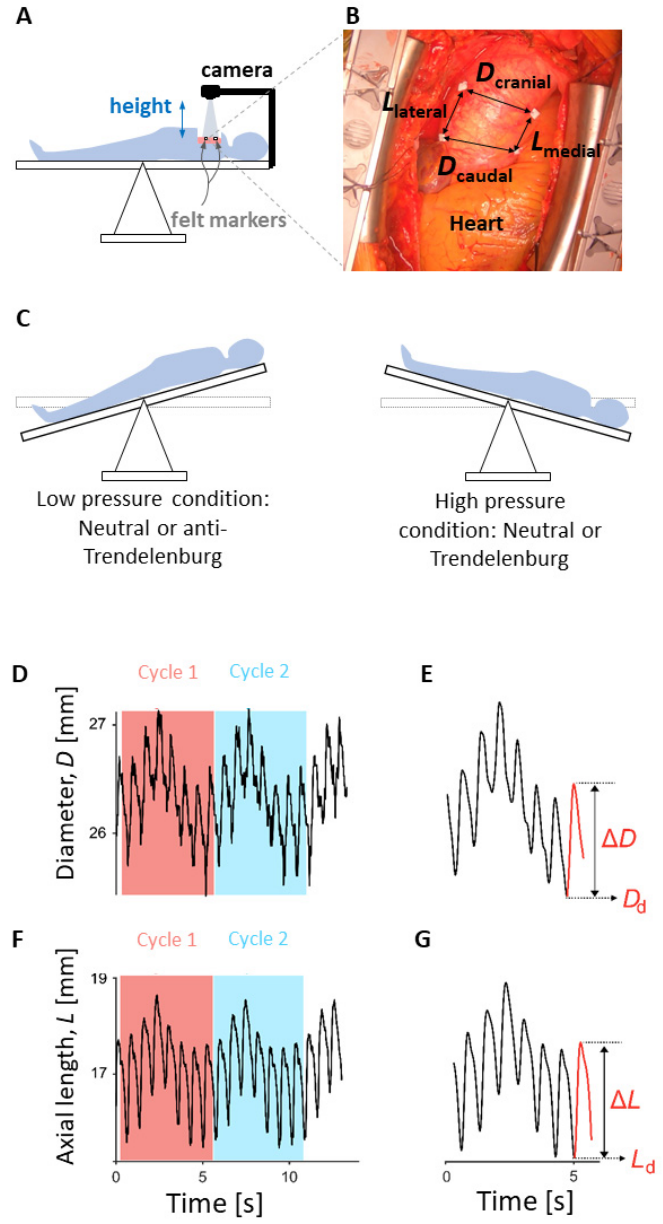
Figure 1. Key elements of the intra-operative, video-based strain measurement method. ( A ): Intra- operative set-up. The remote-controlled camera mounted on a rigid arm attached to the table was positioned at a height of about 40 cm above the imaging plane, as defined by the markers, with a viewing angle close to zero degrees. ( B ): Single video image showing heart on bottom and markers sutured on the adventitia of an ascending aortic aneurysm. Arrows between markers define the positions at which cranial and caudal (circumferential) strains, and medial and lateral (axial) strains were assessed. ( C ): Low and high transmural pressure conditions were created by tilting the table. Tilted table position for low-pressure condition shown is anti-Trendelenburg, while tilted-table position for high-pressure condition shown is Trendelenburg position. Horizontal position of the table is referred to as neutral position. ( D , F ): Examples of diameter and axial length signals, comprising two ventilatory cycles. ( E , G ): Smoothed signals for diameter and axial length, respectively (single ventilation cycles). The variables D d and L d represent magnitudes of diameter and axial length corresponding to diastolic pressure, while ∆ D and ∆ L are deformations of diameter and axial length caused by the change in pressure from diastole to systole (i.e., pulse pressure). 2.2.1. Intra-Operative Set-up and Video Recording Settings A camera (HERO7, GoPro Inc., San Mateo, CA, USA) with a mounting arm (GoPro stick, GoPro Inc., San Mateo, CA, USA) was secured to the surgical table at the head end